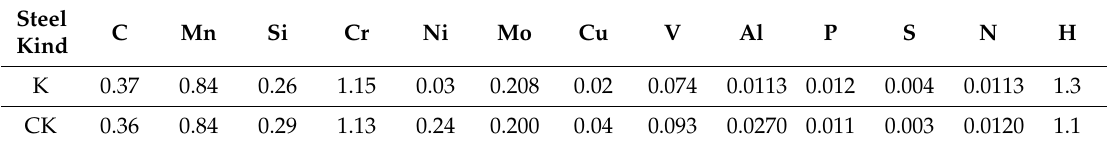
Table 1. Chemical composition of two modifications of 34CrMo4 steel in weight %, hydrogen content is in